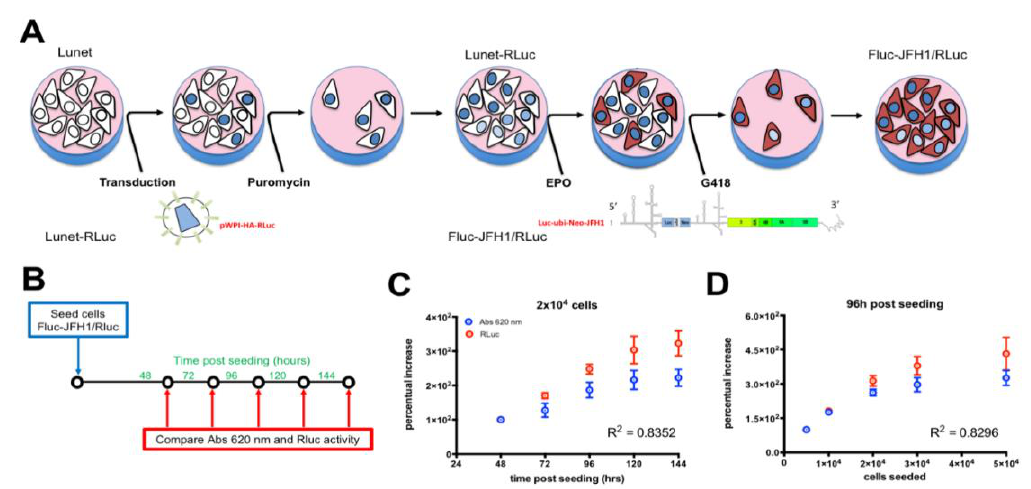
Figure 2. Generation of an HCV subgenomic double reporter replicon cell line allows accurate quantification of cell number. ( A ) Lunet cells were transduced with pWPI-HA-RLuc, mediating expression of the HA-RLuc reporter under control of the EF1 α promoter. Transduced cells were selected using Puromycin to generate Lunet-RLuc cells, allowing to easily monitor cell number and viability by firefly luciferase assays. Subsequently cells were electroporated with in vitro transcribed RNA from plasmid pFKI389Luc-ubi-neo / NS3-3 (cid:48) _dg_JFH. Cells stably replicating HCV subgenomic RNA were selected using G418 (750 µ g / mL) to generate FLuc-JFH1 / RLuc cells, allowing to simultaneously monitor cell number and viral replication by dual luciferase assays. ( B ). Di ff erent amounts of FLuc-JFH1 / RLuc cells were seeded either in 96- (for MTT assays) or 24- (for RLuc assays) well plates and incubated for the indicated time points before being processed as described in the Materials and Methods section. ( C ) Measurements relative to 2 × 10 4 cells seeded / cm 2 , cultured for the indicated time, are expressed as the percentage of the signals obtained 48 h post-seeding. The R 2 relative to the linear regression between Abs at 620 nm (blue circles) and RLuc values (red circles) is shown. Data are mean + standard error of the mean relative to three independent experiments. ( D ) Data relative to the indicated number of cells seeded / cm 2 and cultured for 96 h, are expressed as the percentage of the signals obtained for 5 × 10 3 cells seeded / cm 2 . The R 2 relative to the linear regression between Abs 620 nm (blue circles) and RLuc values (red circles) is shown. Data are mean ± standard error of the mean relative to three independent experiments.